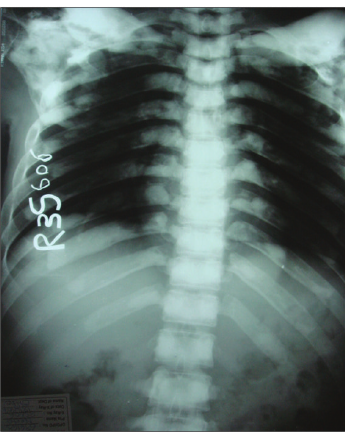
Figure 6: PA chest showing generalised osteosclerosis in the thoracic cage and both clavicular bones.